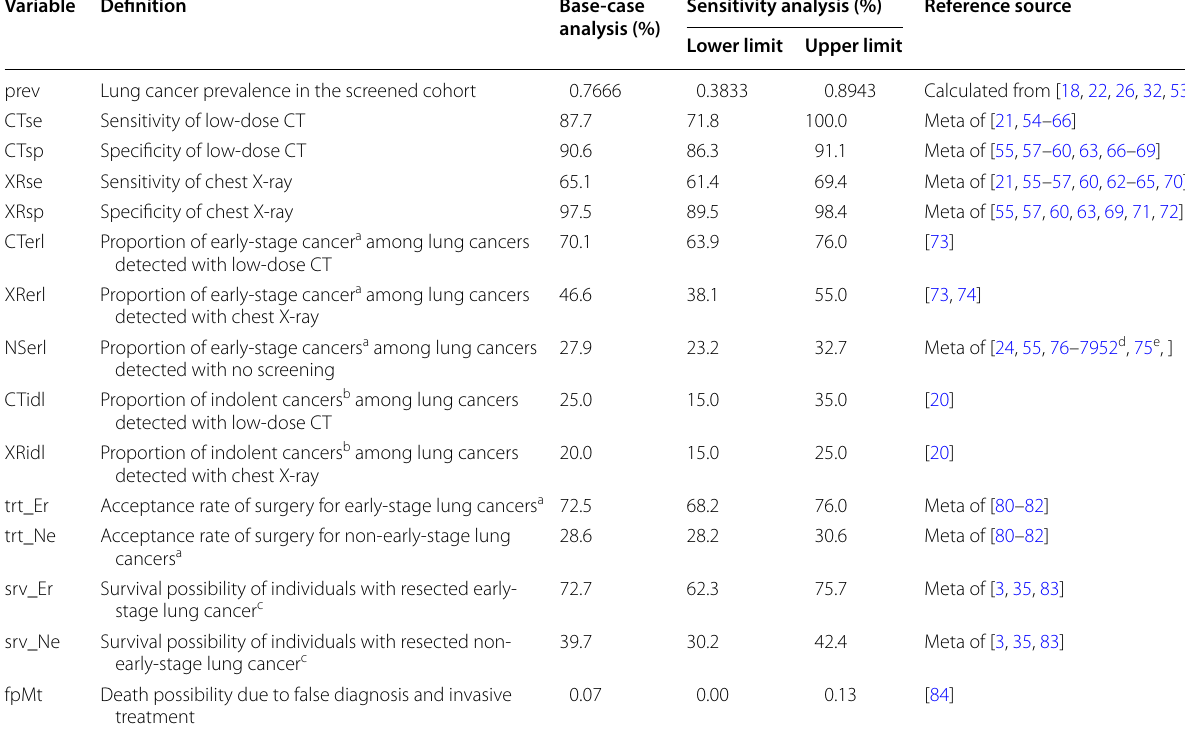
Table 1 Parameter settings in the decision tree for lung cancer screening in urban